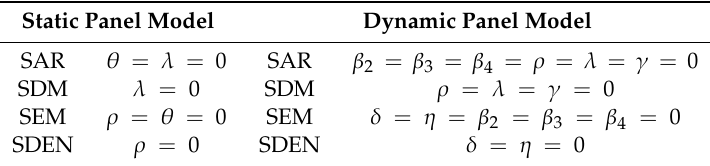
Table 2. Spatial model structure parameter